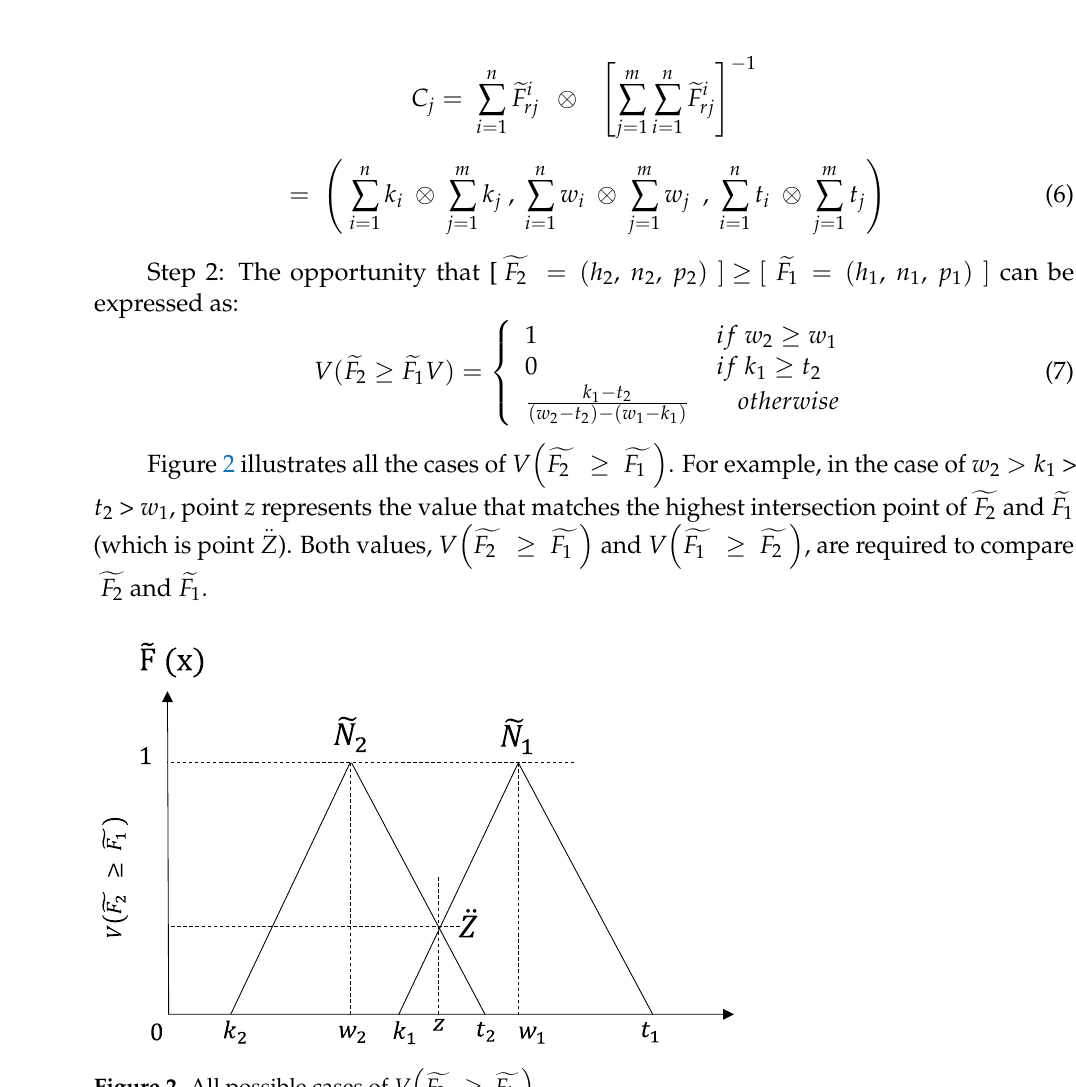
Figure 2. All possible cases of (cid:1848)(cid:3435)(cid:1832) (cid:2870) (cid:3562) ≥ (cid:1832) (cid:2869) (cid:3562)(cid:3439).